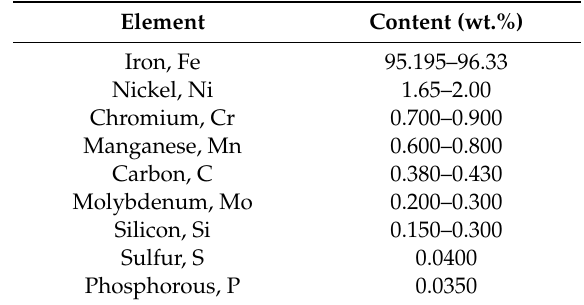
Table 1. Chemical composition of AISI 4340 alloy steel [22].